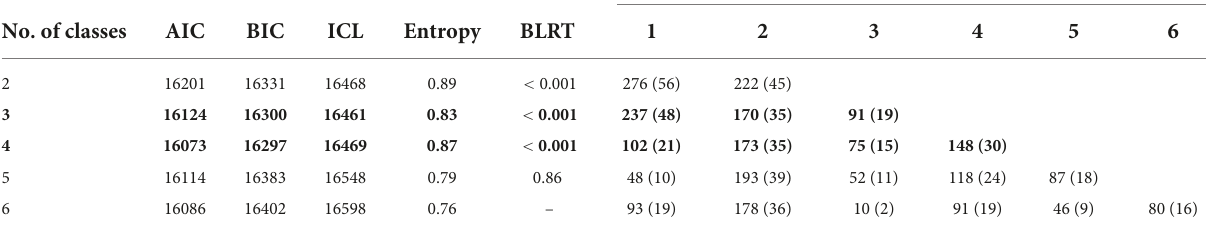
TABLE 1 Model fit statistics and n (%) by class for latent profile models with two to six classes.